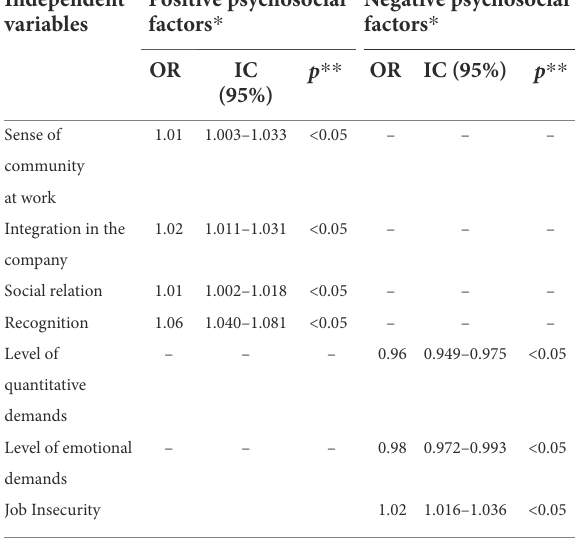
TABLE 3 Statistical association between psychosocial factors ( * ) and level of job satisfaction ( ** ). Level job satisfaction **